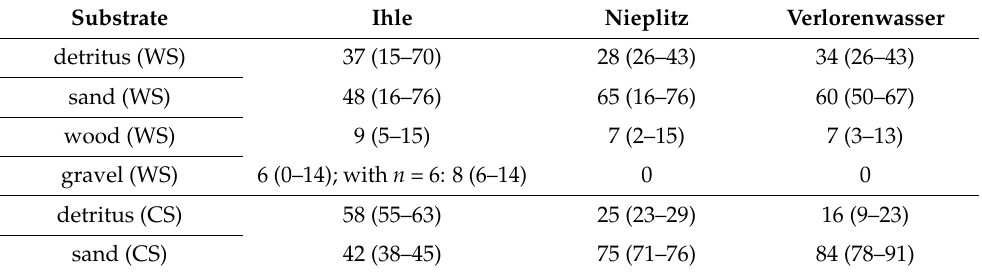
Table 1. Area percentage (min.–max.) of the substrates in % of the wood sections (WS, n = 9) and the control sections (CS, n = 3) of the streams Ihle, Nieplitz and Verlorenwasser. Gravel was not present